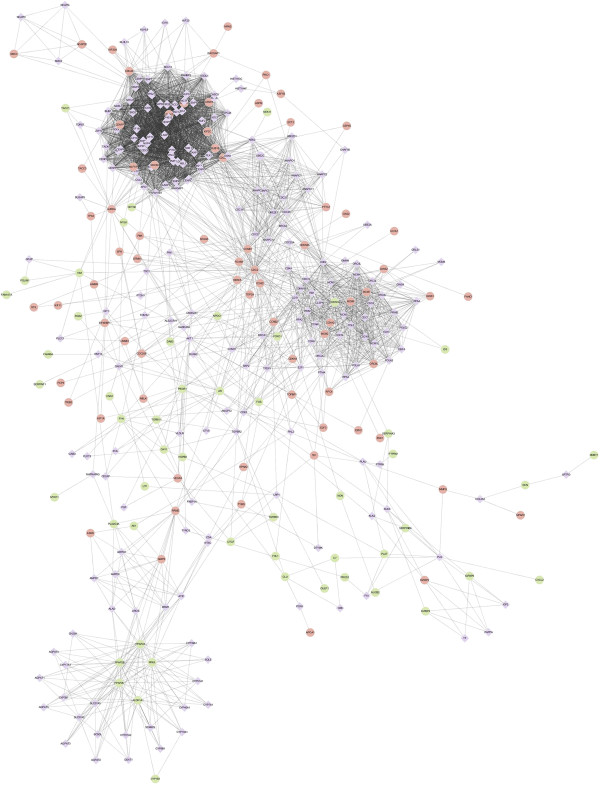
Gene-gene interaction network constructed by NetBox software. The purple rhombuses are the LINKERs having the significant interactions (p < 0.05) with differentially expressed genes (DEGs), green circle are the down-regulated DEGs, and red circles are the up-regulate DEGs.